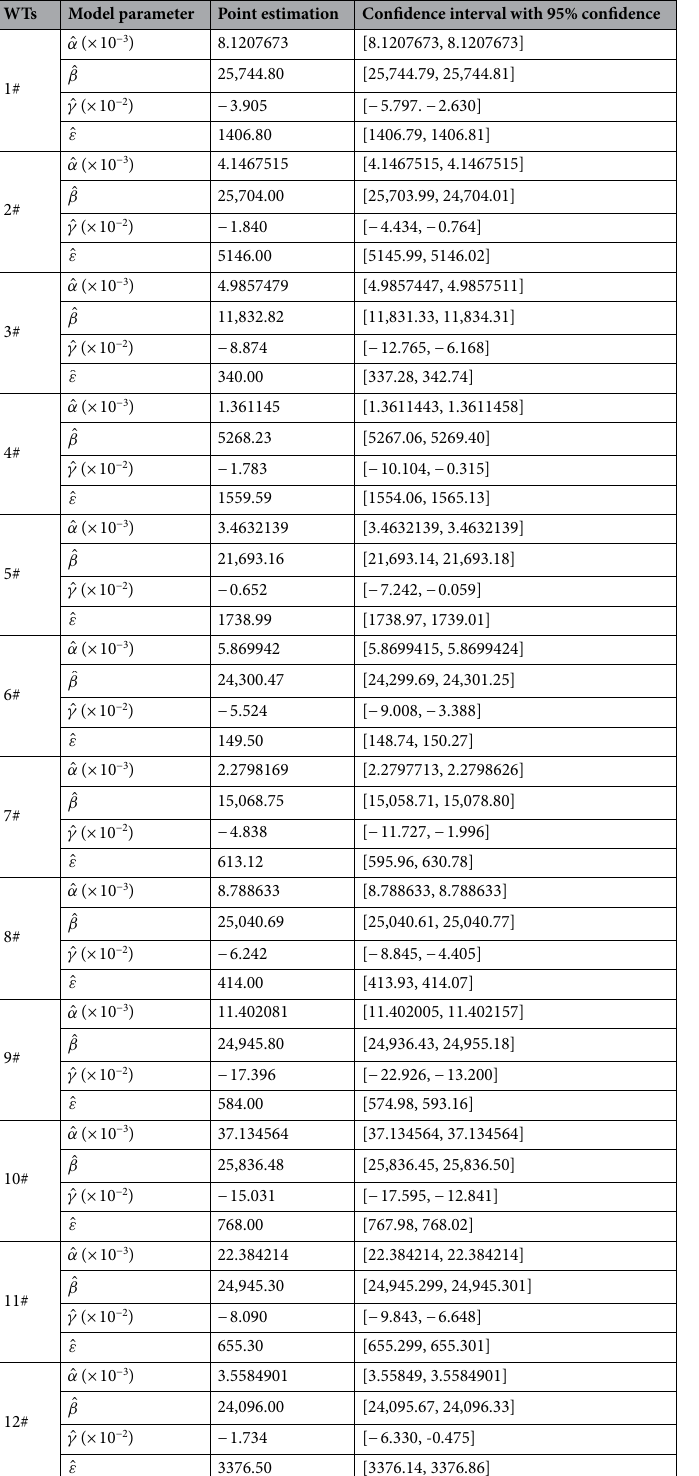
Table 1. Point estimation and interval estimation of model